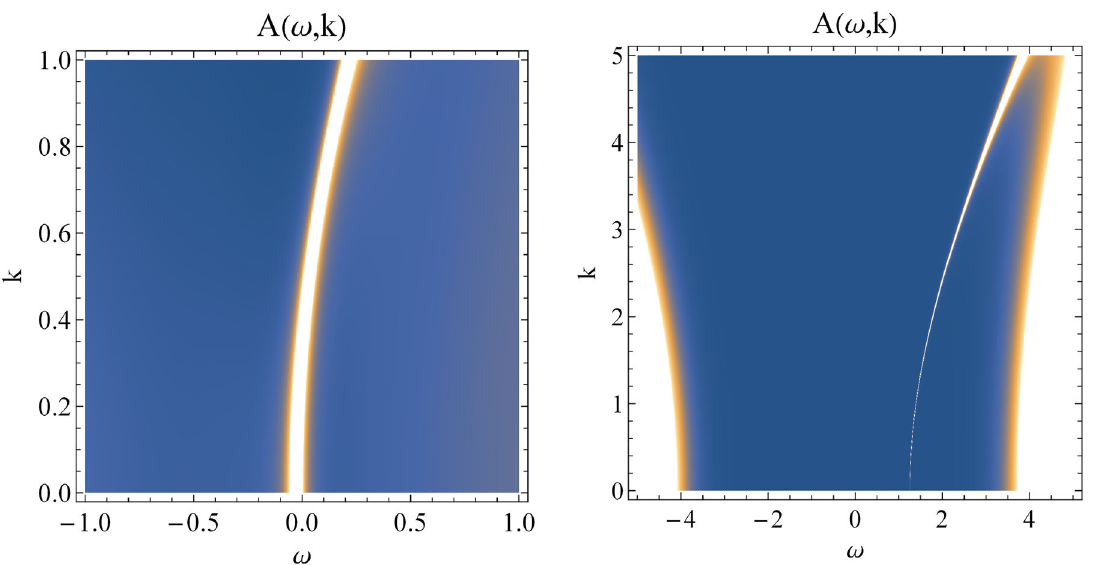
Fig. 2 Density plots of spectral function A (ω, k ) for α = 5 and (cid:5) = 2 at T = 0 . 01. Left plot is for η 2 = 0 . 5 and right plot for η 2 = 4 Fig. 3 Spectral function A (ω, k ) for sample k with α = 5 and (cid:5) = 2 at T = 0 . 01. Left plot is for η 2 = 0 . 5 and right plot for η 2 = 4